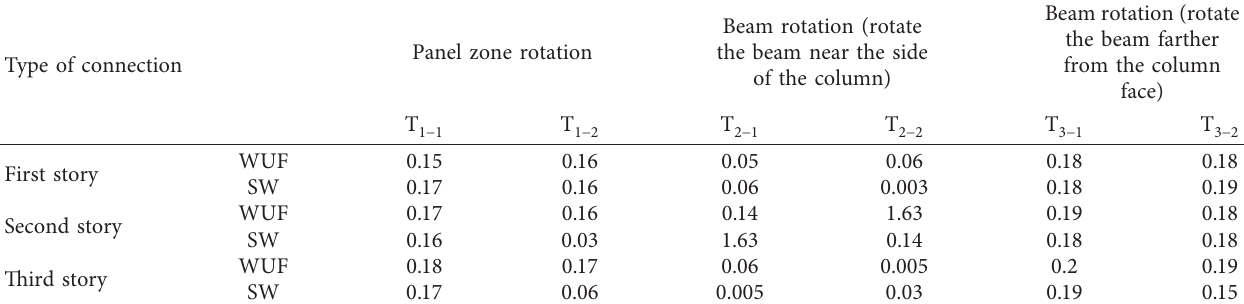
Figure 19: The values of rotation on SW and WUF in a three-story frame ( t � 15s). (a) The rotation of the two ends of the beam in the WUF connection on the first and second stories. (b) The rotation of the two ends of the beam in the SW connection on the first and second stories. (c) The rotation of the two ends of the beam in the WUF connection on the third story. (d) The rotation of the two ends of the beam in the SW connection on the third story. Table 3: The values of rotation on SW and WUF (units in